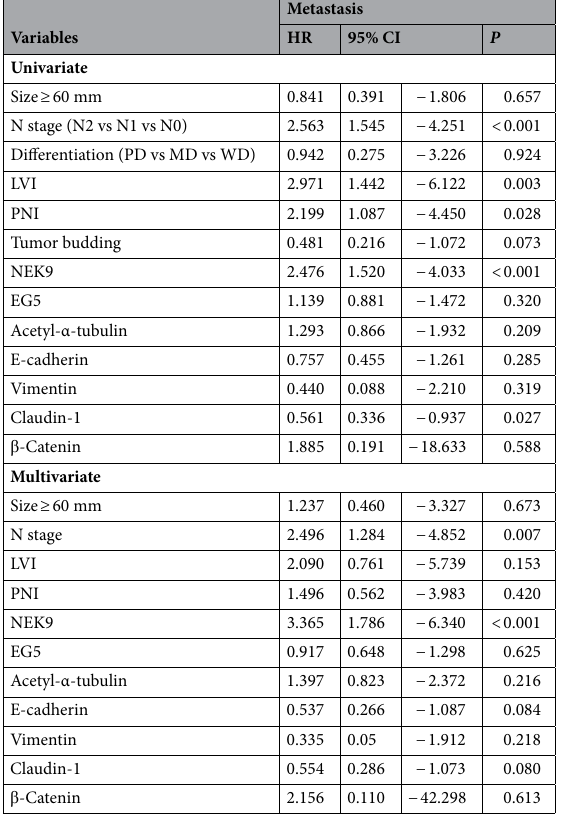
Table 2. Univariate and multivariate regression analysis of metastasis biomarkers in the study cohort. WD well differentiated, MD moderately differentiated, PD poorly differentiated, LVI lymphovascular invasion, PNI perineural